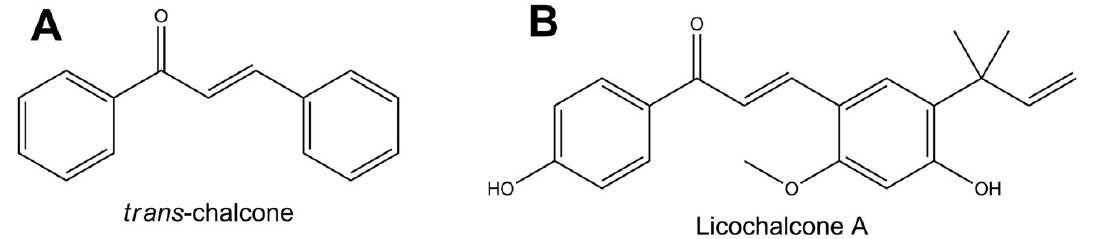
Figure 1. Structures of the two chalcones tested. Table 1. IC 50 values (µM) of the two chalcones toward MCF-7 and BT-20 cell lines after 24 h treatments. Cell Lines